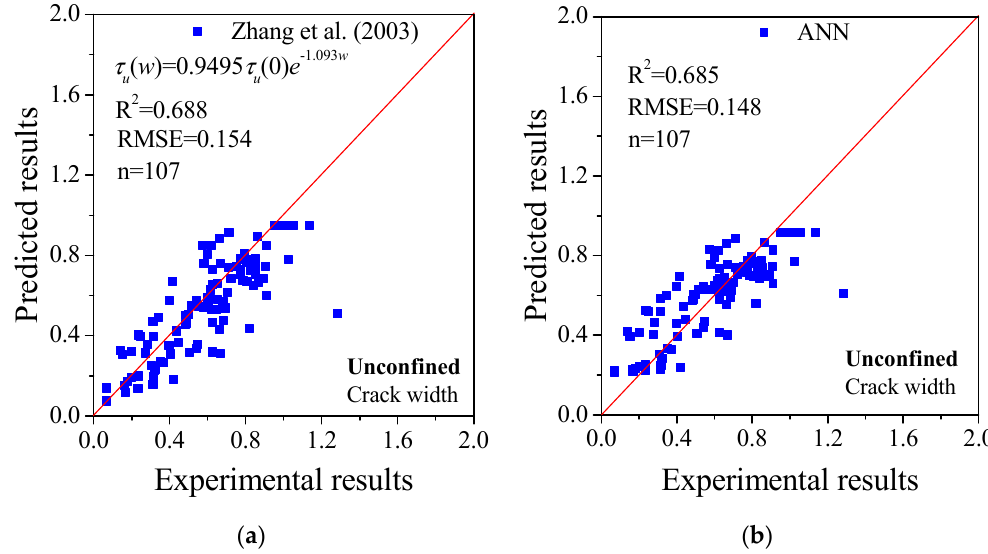
Figure 6. Comparison between the existing analytical models and ANN method considering only crack width as input for specimens without stirrups (unconfined) (note: τ u ( w ) is the bond strength of specimen with crack width w , τ u (0) is the bond strength of specimen without corrosion damage and w is the crack width on the surface of specimen): ( a ) Zhang et al. (2003) [53]; ( b ) ANN.